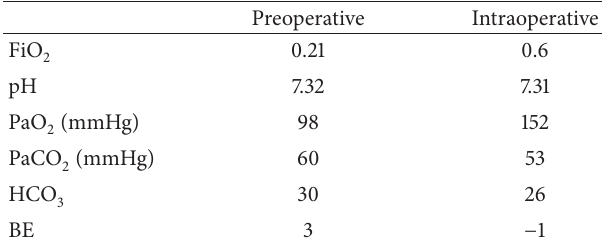
Table 1: Arterial blood gas